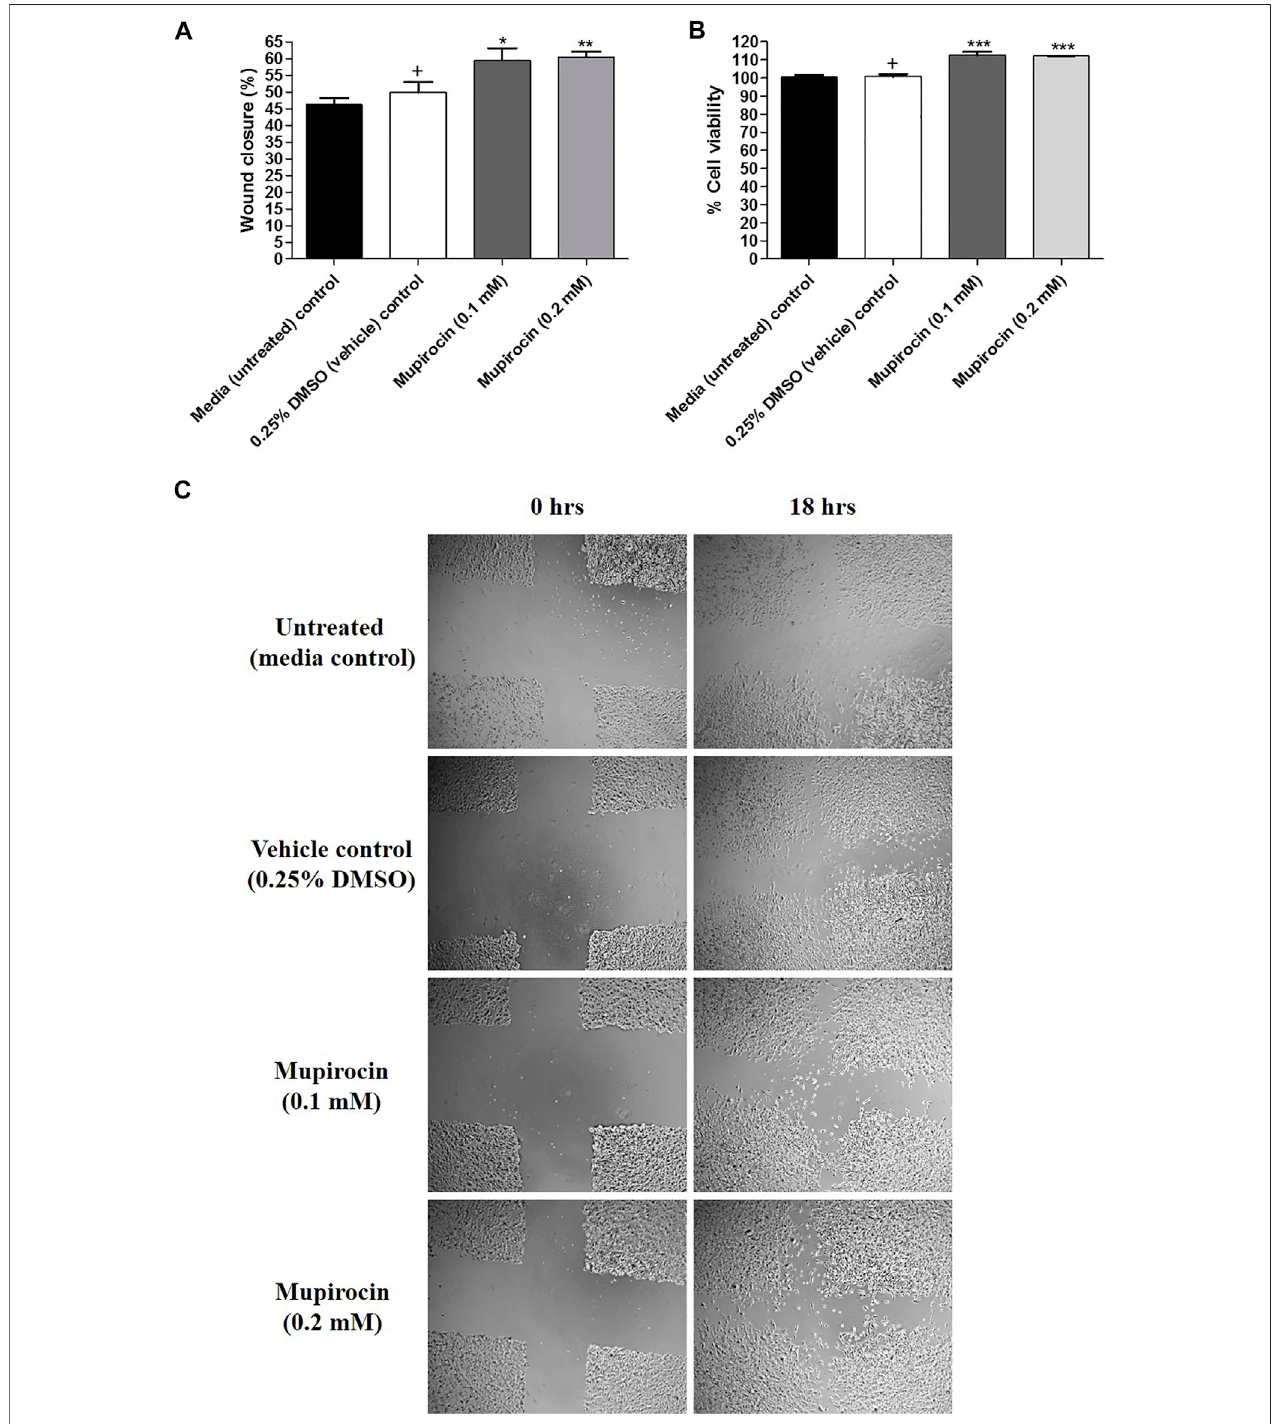
FIGURE3|(A) Percentage(%)woundclosure, (B) percentage(%)cellviabilityand (C) lightmicroscopeimages(4xmagni fi cation)representingthepercentage(%) woundclosureofhumankeratinocytes(HaCat)treatedwithmupirocin(at0.1and0.2 mM)after18 h.Controlsincludedcellsgrowninmedia(untreated)andcellstreated with 0.25% DMSO (vehicle control). Data shown are mean ± SD ( n = 3). * p < 0.05, ** p < 0.01 and *** p < 0.001 indicates statistical signi fi cance when compared to the 0.25% DMSO vehicle control (+). Statistical analysis was done using one-way ANOVA followed by Tukey ’ s multiple comparison test.